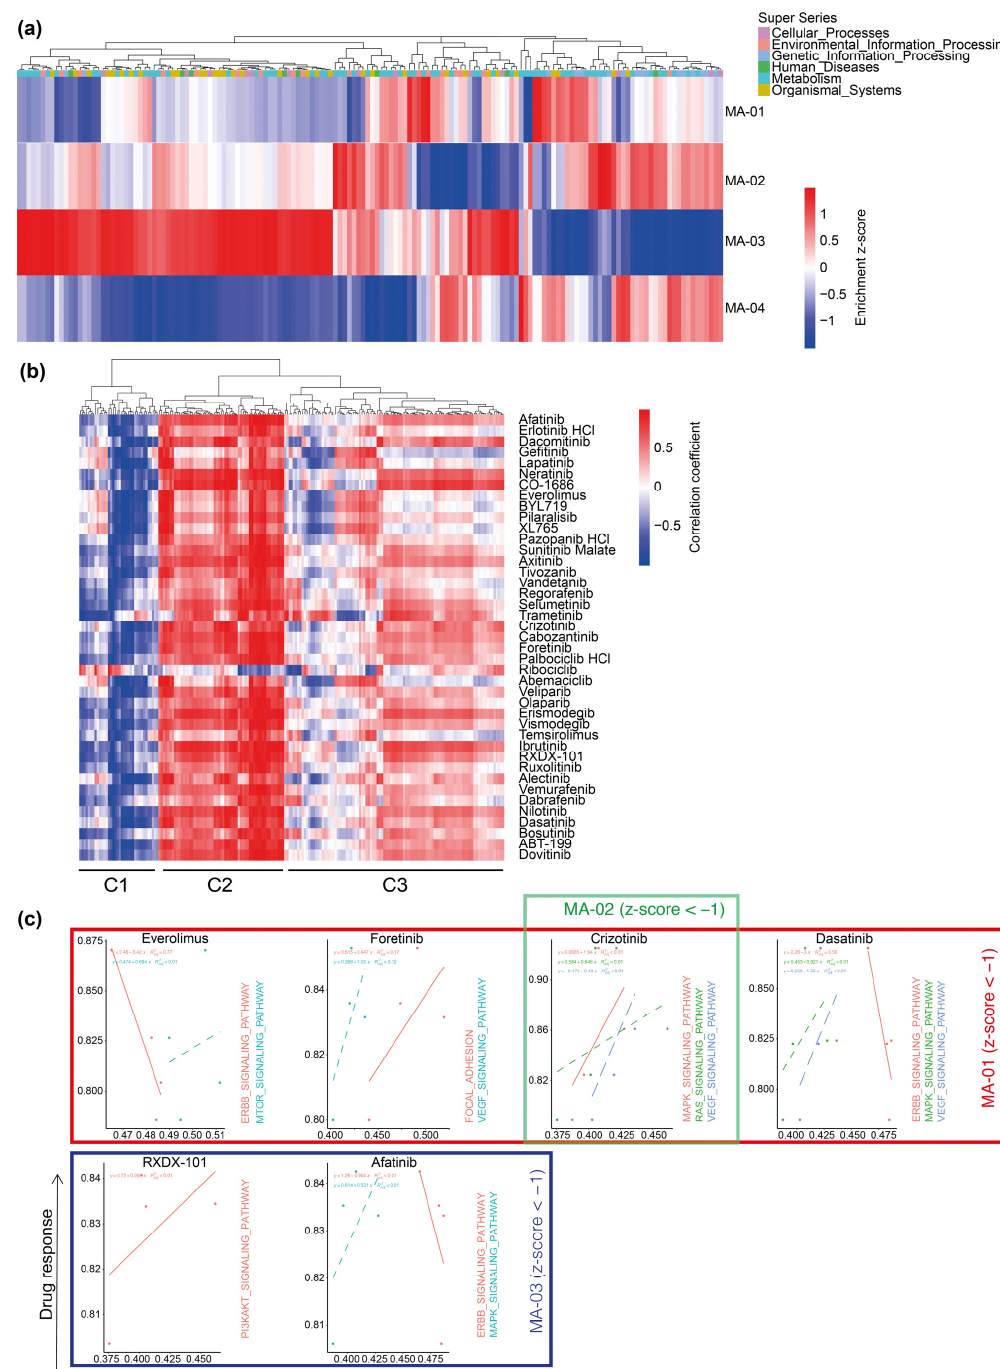
Figure 5. Correlation of pathway enrichment in the parental tumor and drug response of corresponding PD-GBOs. ( a ) Heatmap illustrating inter-sample z-score of 193 KEGG pathways enrichment levels from four high-grade glioma tissues. KEGG pathway super series groups are color-coded. Raw values are provided in Supplementary Table S2. ( b ) Pearson correlation coefficient of drug response score and specific interindividual KEGG pathway enrichment levels visualized as a heatmap. On the basis of the correlation coefficient with drug response, pathways are divided into three clusters (C1, C2, and C3). For individual pathways within clusters, see Supplementary Table S3. ( c ) Linear regression of PD-GBO drug response score and enrichment of annotated biologically related pathways (KEGG drug